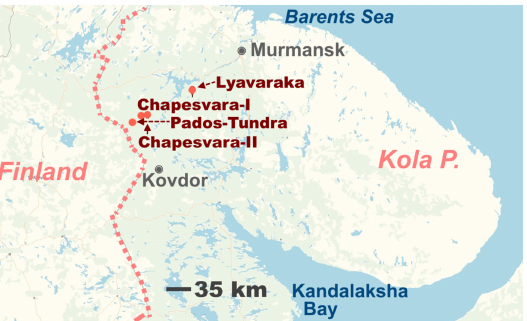
Figure 1. Location of the investigated complexes in the Kola Peninsula, northwestern Russia. The Lotmvara-I sill is located about 20 km northwest of the Pados-Tundra intrusion (see Figures 2 and 3 for additional